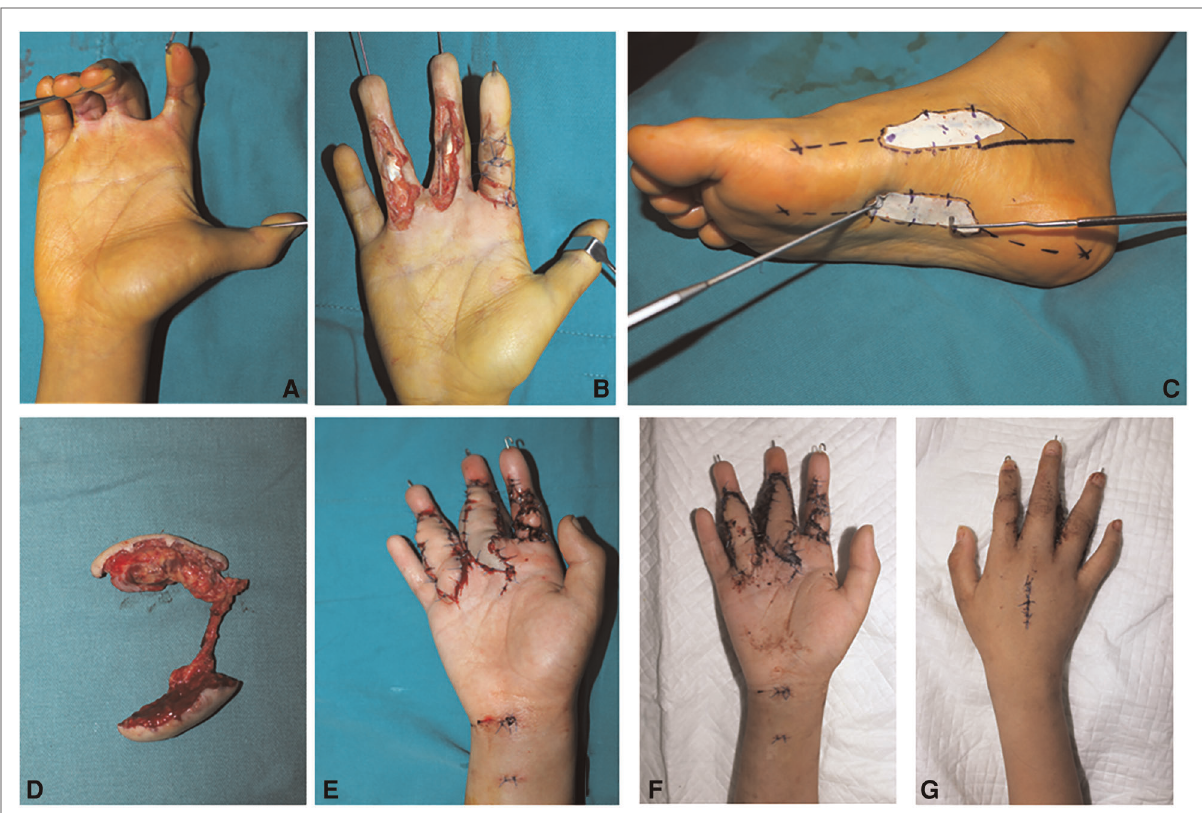
FIGURE 2 Case 1: Pre-operative view of a scar contracture of the fi nger ( A ). The defect of the fi nger following scar release ( B ). A two-lobulated MPAP fl ap (7×3 cm 2 and 6×3 cm 2 ) is marked ( C ). The two-lobulated MPAP fl ap is harvested ( D ). The MPAP fl ap is transferred to the defect in the fi nger ( E ). Appearance at 2 weeks of follow-up ( F,G